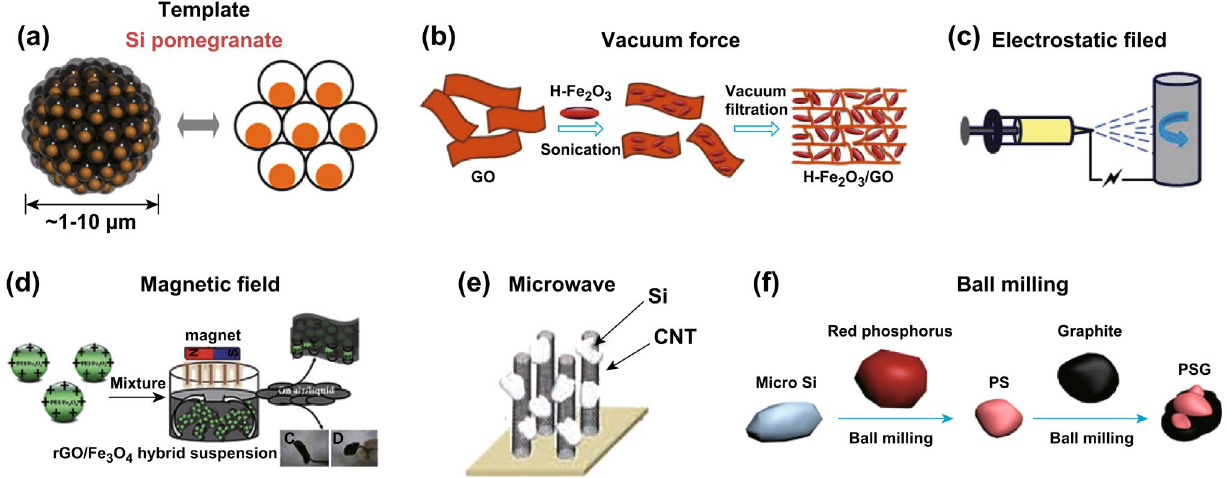
Fig. 2 Assembly methods with the assistance of external forces or fields. a Schematic of silicon pomegranates. Reprinted with permission from Ref. [30]. b Schematic of the fabrication process for H‑Fe 3 O 4 /GS hybrid films. Reprinted with permission from Ref. [39]. c Schematic of the gradient electrospinning and controlled pyrolysis method. Reprinted with permission from Ref. [45]. d Schematic of the synthesis rGO/Fe 3 O 4 hybrid paper. Reprinted with permission from Ref. [52]. e VA‑CNTs/Si structure. Reprinted with permission from Ref. [56]. f Schematic of the fabrication processes for nanostructured P‑doped Si/graphite composites. Reprinted with permission from Ref.